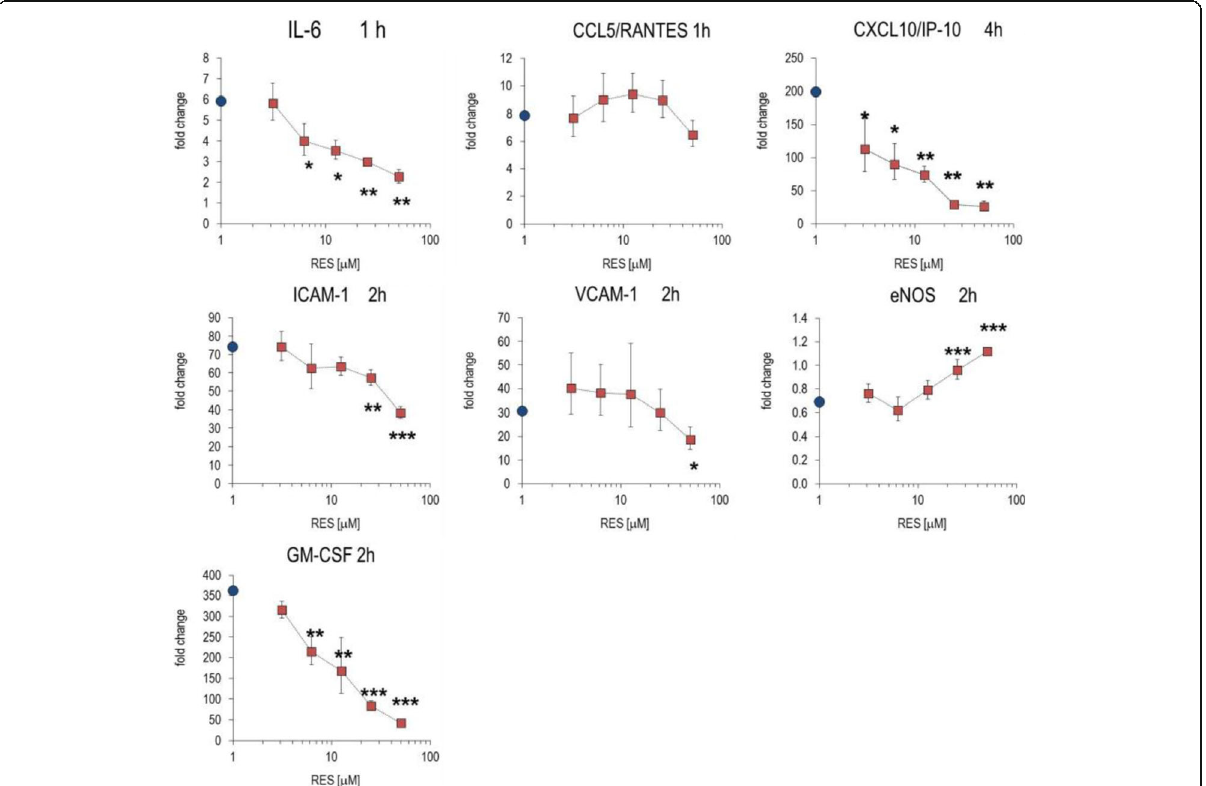
Fig. 7 Impact of RES on gene expression in activated HUVECs. Cells were incubated with substances, activated with 10 ng/mL TNF- α and cultured for 1, 2 and 4 h. Gene expression was quantified by RT-PCR and the data expressed as fold change compared to levels observed in unstimulated cells (set as 1). The data at the time point of maximal changes in gene expression are shown (indicated in the panels). Mean ± errors (see ref. [11]) of triplicate cell cultures are given. * p < 0.05, ** p < 0.01 *** p < 0.001 (versus TNF- α -stimulated cells). Symbol on the y-axis show the values obtained with ‘ TNF- α alone ’ treated